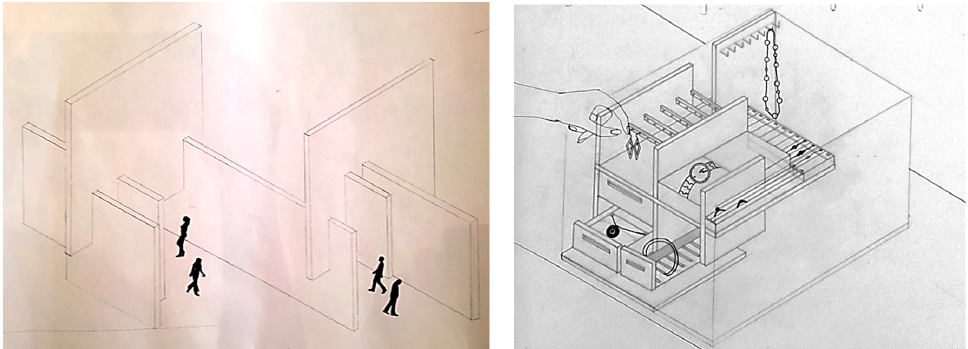
Figure 7. Planar exploration across scale and functionality.